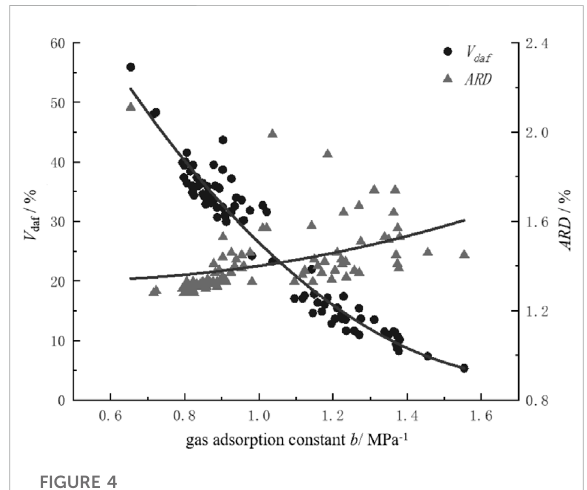
FIGURE 4 Relationship between parameters V daf , ARD and b in 90 coal